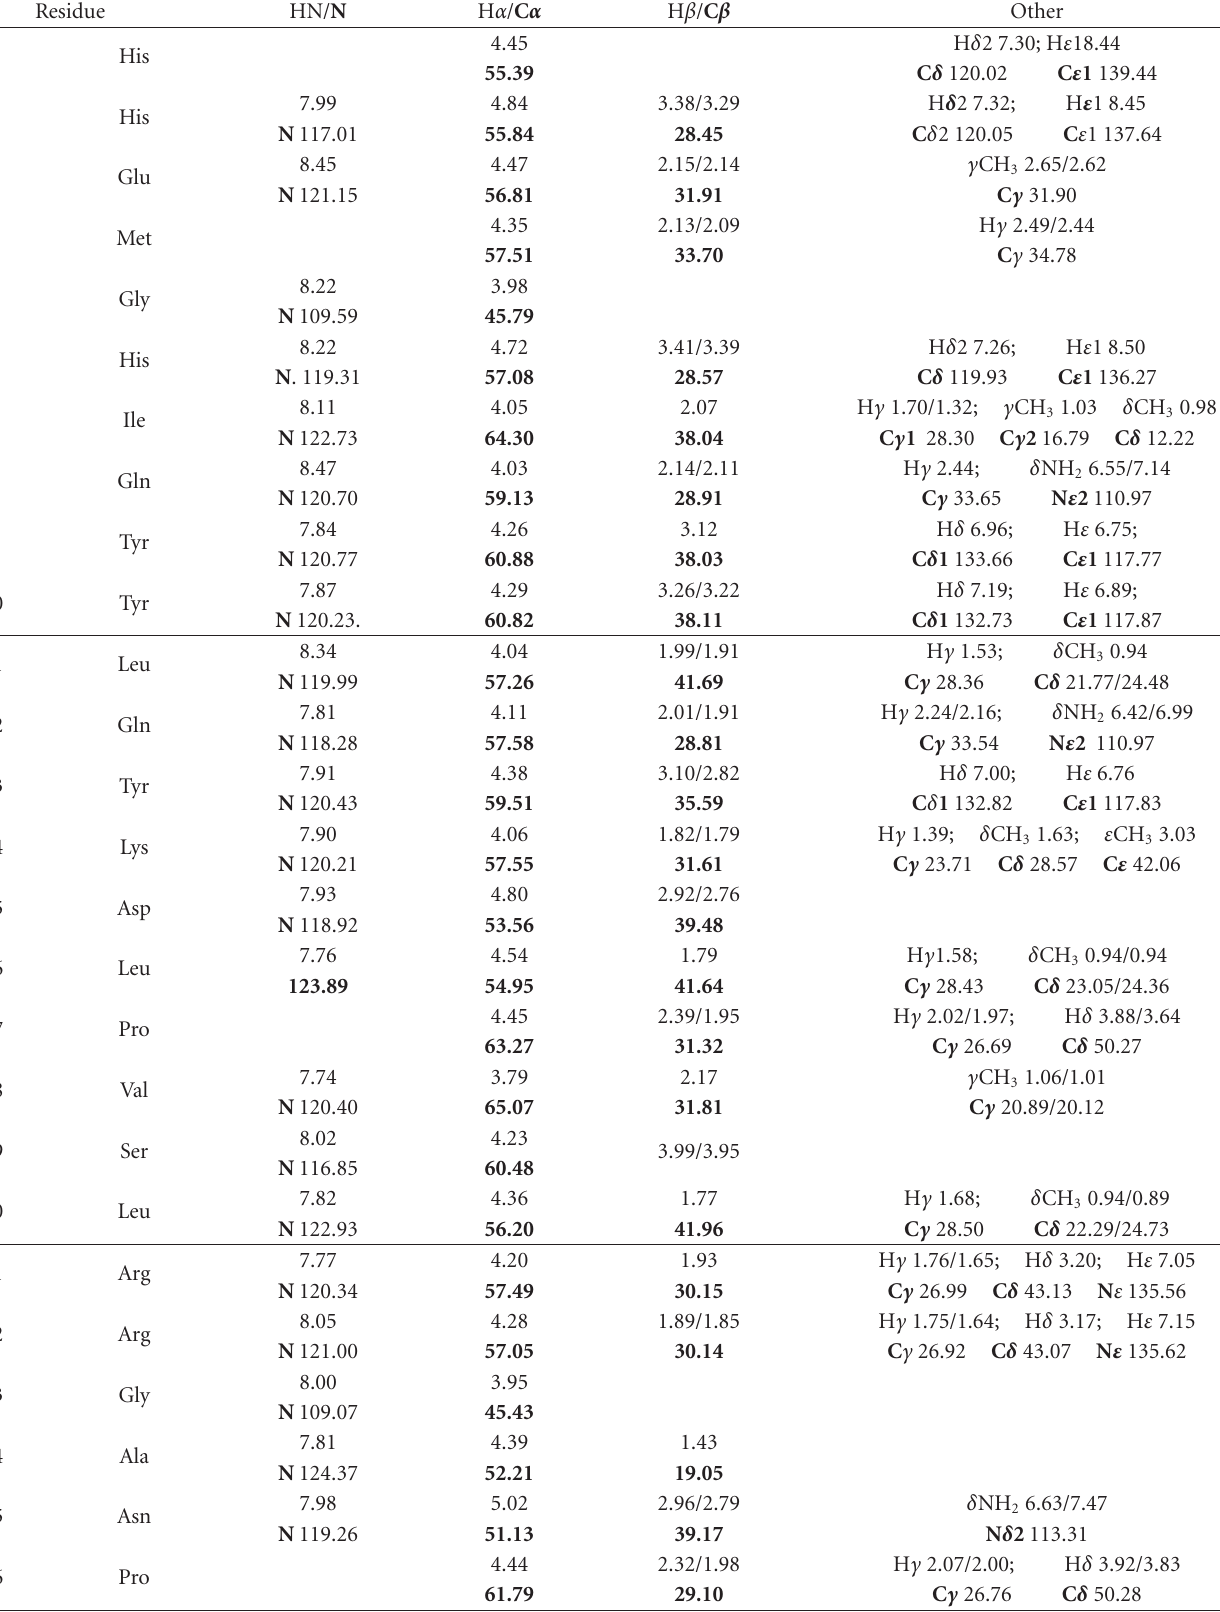
Table 1: 1 H, 15 N, and 13 C chemical shifts (ppm) of the residues in the Zn 2+ -ACE N (37) peptide at 298K (H2O/TFE- d2 34%/66% v/v. pH =